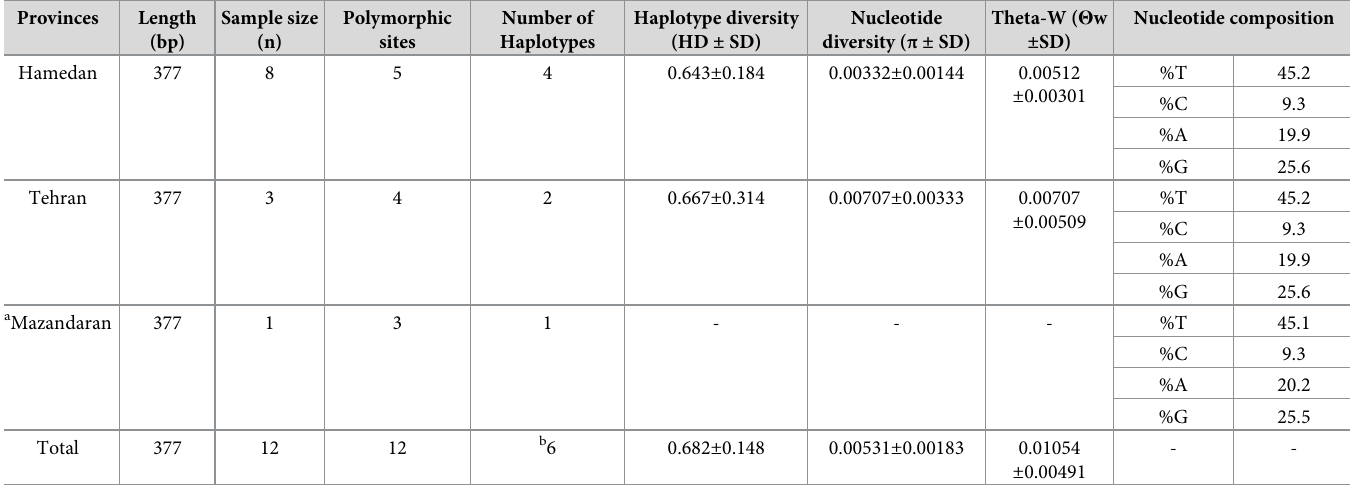
a Due to the small number of sequences, it was impossible to estimate haplotype and nucleotide diversity and Theta-W indices for the Mazandaran case (access no. MZ362434), so it did not consider for the estimation individually. b One haplotype is common in Hamadan and Tehran